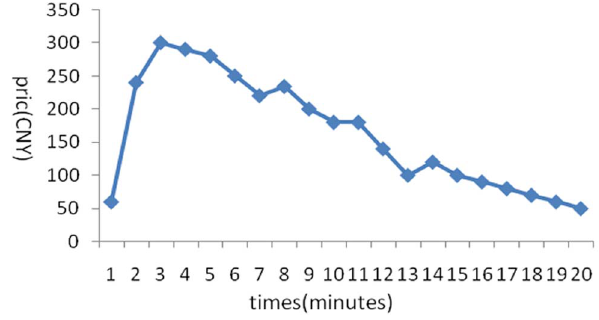
Figure 4. First Experiment of a Unilaterally Price-Falling Situation with